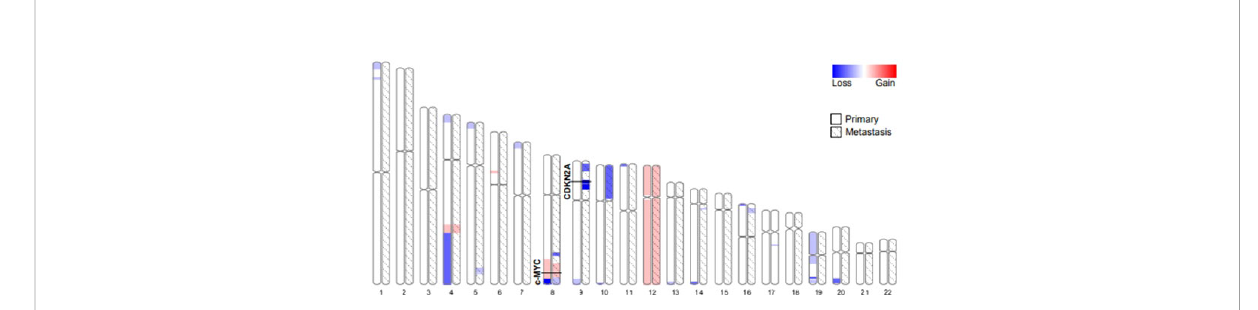
FIGURE 4 Autosome ideograms comparing copy number variations of the primary tumor (blank) and a metastasis (hatched). Both copy number pro fi les have been derived from DNA methylation arrays. The magnitude of gains (red) and losses (blue) are represented by a color gradient. The two loci speci fi cally addressed in this study ( c-Myc and CDKN2A ) are